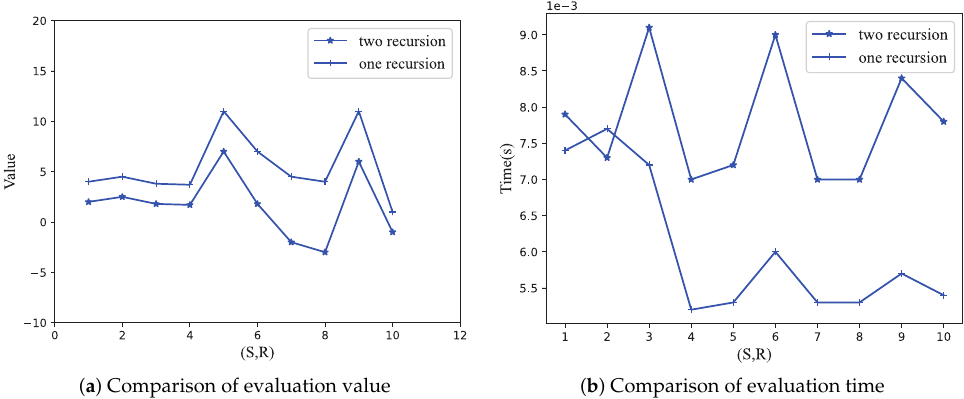
Figure 6. Comparison of the evaluation of one move and two moves ahead. The vertical axis indicates the evaluation results, f , in ( a ) and indicates the evaluation time in ( b